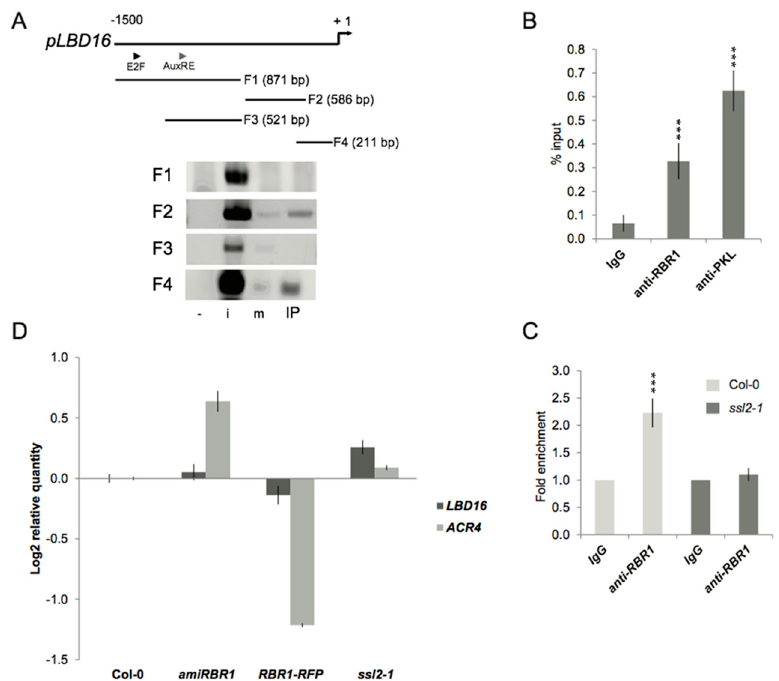
Figure 4. PKL recruits RBR1 to the LBD16 promoter. ( A ) Chromatin immunoprecipitation (ChIP)-PCR analysis of different LBD16 promoter fragments (F1–F4) precipitated with RBR1 antibody using chromatin extracted from 10 DAG Col-0 roots. Triangles show the position of the predicted E2F consensus (E2F) binding site, the AuxRE motif and the transcription start site (TSS); +1 labels the translation initiation site. -: non-template control, i: input DNA, m: IP with IgG, IP: IP with anti-RBR1 antibody. ( B ) ChIP-qRT-PCR analysis of RBR1 and PKL binding to LBD16 promoter fragment (F4) in 5 DAG wild-type Columbia roots. Bar graphs show quantification of qRT-PCR products from ChIP experiment using anti-RBR1 and anti-PKL antibody, expressed as % input. Data from two biological replicates are shown as means ± SD of the mean; significance was evalu- ated by two-sided t -test at p < 0.001(***) ( C ) ChIP-qRT-PCR analysis of RBR1 binding to the LBD16 promoter in ssl2-1 background. Bar graphs show quantification of qRT-PCR products from ChIP experiment using anti-RBR1 antibody on chromatin extracted from 10 DAG Col-0 and ssl2-1 roots. Data from two biological replicates are shown as means + SD of the mean; significance was evalu- ated by two-sided t -test at p < 0.001 (***). ( D ) qRT-PCR analysis of LBD16 and ACR4 gene expres- sion in 10 DAG roots expressing 35S::amiRBR1 ( amiRBR1 ), pRBR1::RBR1-RFP ( RBR1-RFP ) and in the PKL mutant ssl2-1 compared with Col-0. The expression levels were normalized to At1g61670 and At3g03210 (mean stability value M = 0.0413), and data (log2) from three technical replicates are shown as means ± SD. Interaction between PKL and RBR1 proteins suggested that they act on a common pathway to regulate LR formation; thus, the presence of PKL on the LBD16 promoter was tested by ChIP assay. Quantitative real-time PCR (qRT-PCR) analysis of PKL-bound chro- matin samples revealed that PKL bound to the LBD16 promoter and that binding took place within the same proximal promoter region (Fragment F4) to which RBR1 binds (Fig- ure 4B). To assess whether RBR1 binds directly or through interaction with PKL to the LBD16 promoter, we examined promoter binding in a ssl2-1 root that lacked the full- length PKL protein (Figure S3B). ChIP with the anti-RBR1 antibody failed to show any enrichment of the LBD16 promoter fragment (Figure 4C). That PKL interacted with RBR1 and promoter targeting was abolished when the PKL protein was absent collectively in- dicate that binding of the complex to the LBD16 promoter took place through PKL. 2.5. Transcriptional and Functional Analysis of the Effect of RBR1 and PKL Proteins on LBD16 Expression